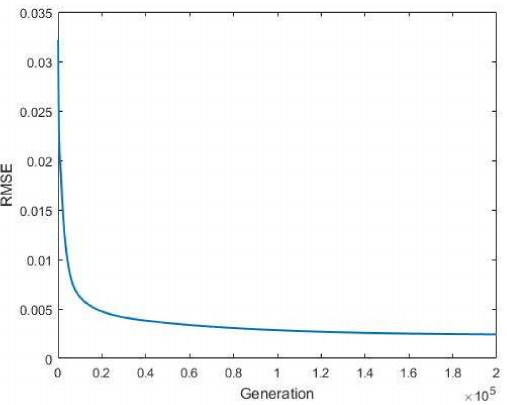
Figure 12. Learning rate curves ( g : 2,000,000, η : 0.8, α : 0.5, H n : 20).